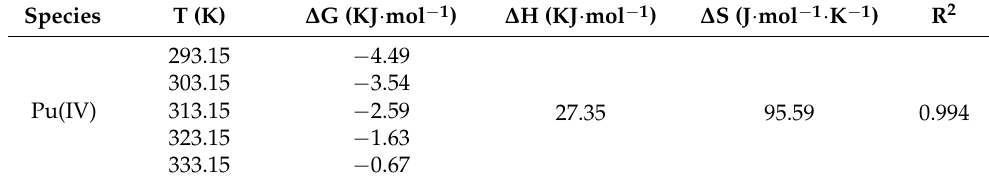
Table 6. Adsorption thermodynamic parameters of Pu(IV).